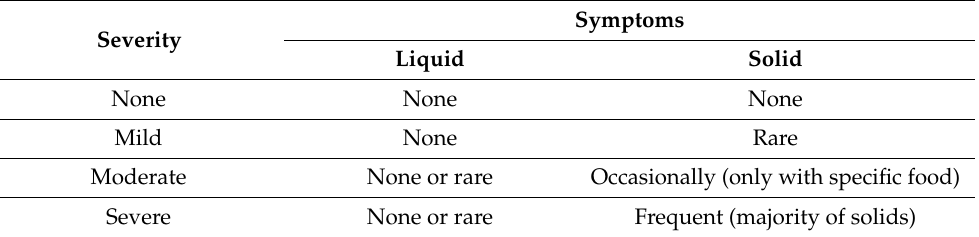
Table 1. Bazaz dysphagia score.